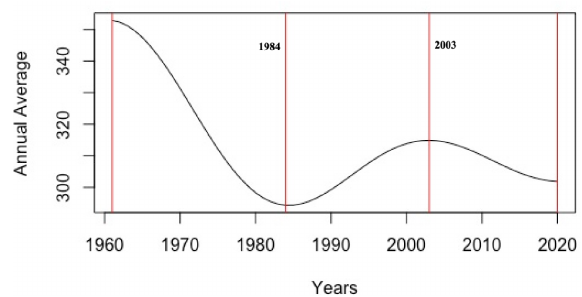
Figure 19. The EAWD trend as a function of the average rainfall per